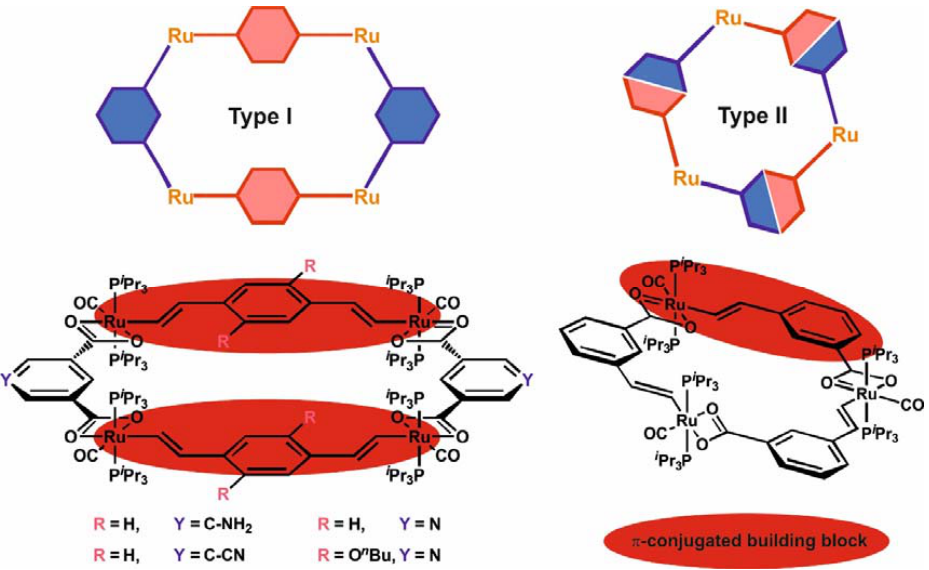
Figure 1. Vinylarylene ‐ bridged ruthenium macrocycles of types I and II.